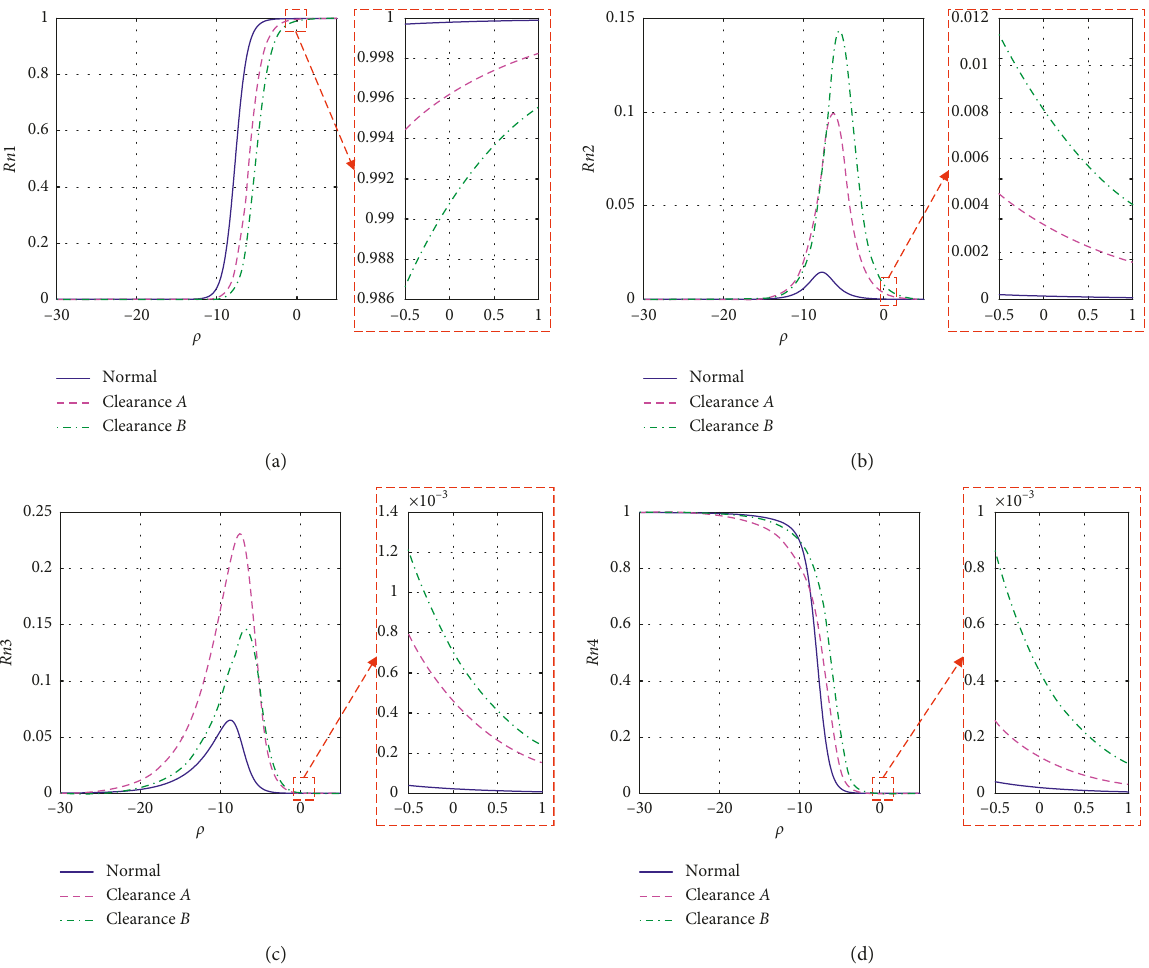
Figure 3: Rn change with indefinite constant ( A